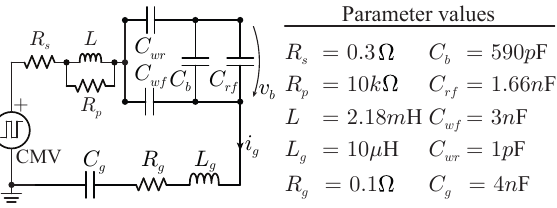
Figure 10. Parasitic components of the three-phase PMSM.